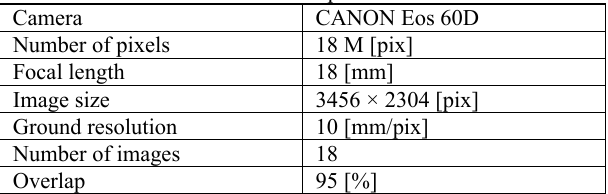
Figure 4. Result of images taken at ground level